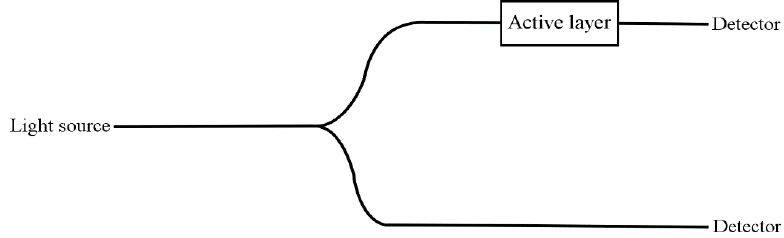
Figure 13. Self-referencing arrangement of the sensor. Lines represent optical fibres.